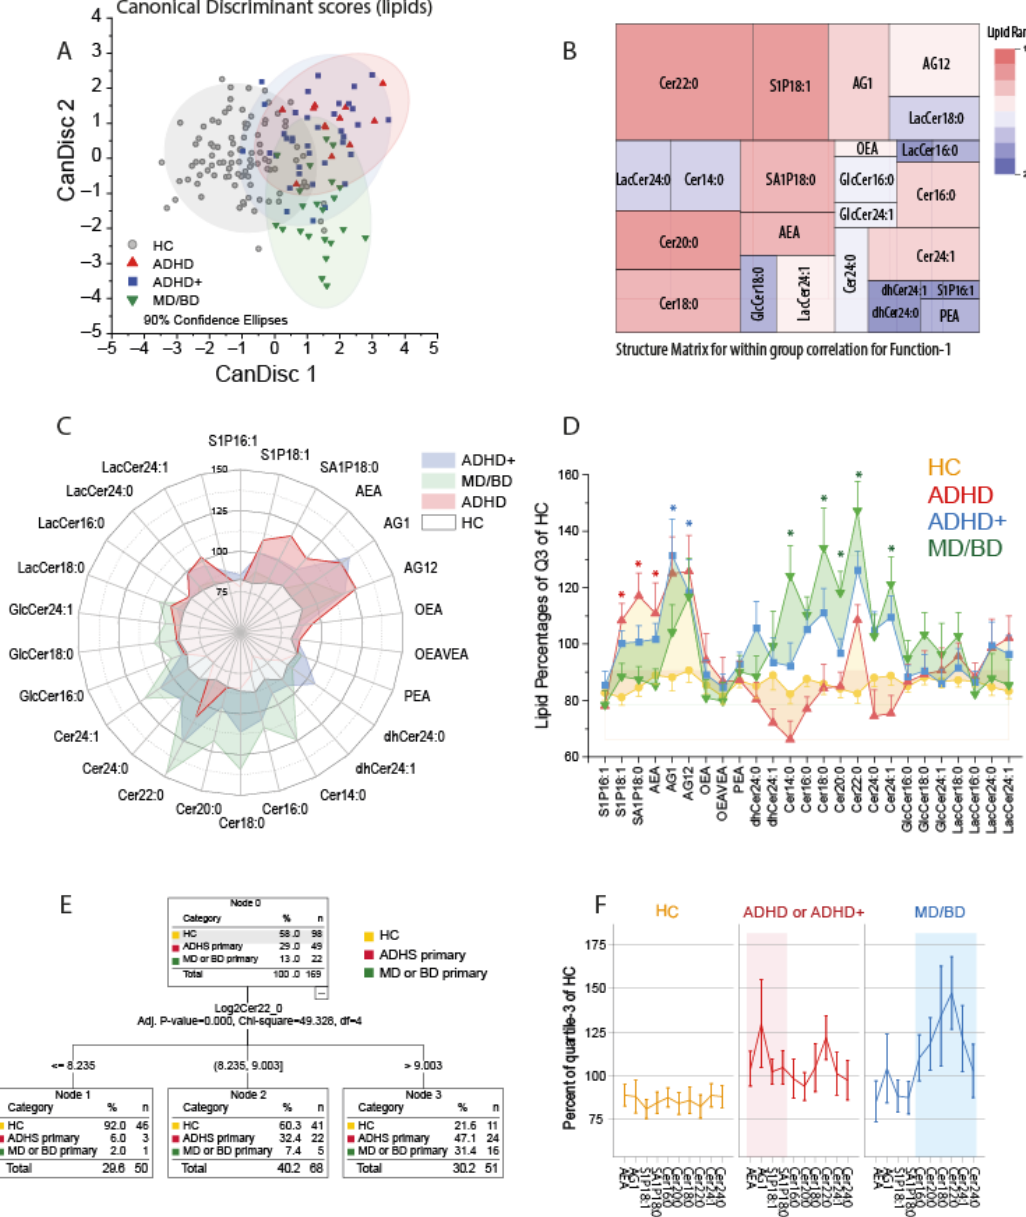
Figure 1. Canonical Discriminant Analysis, CHAID analysis and lipid profiles. ( A ): The scatter plots show the CanDisc scores for the first two functions in patients with attention-deficit/hyperactivity disorder (ADHD), ADHD with comorbidity of major depression (MD) or bipolar disorder (BD) (ADHD+), patients with MD/BD without ADHD, or healthy controls (HC). Each scatter shows one subject. The ellipses show the 90% confidence intervals (CI). Samples sizes: n = 12 ADHD, n = 37 ADHD+, n = 22 MD/BD, n = 98 HC. ( B ): Tree map of the CanDisc structure matrix for function-1, which mainly discriminates between patients and healthy controls. The CanDisc structure of function-2 is in Supplementary Figure S1A. The sizes of the rectangles and the colors reveal the relative importance of the respective lipid for the discrimination of the groups. The sizes are the within-group correlations, and the colors show the ranking. ( C ): Polar plot of the group means of lipid concentrations normalized to percentages of the 75% quantile of healthy controls. Bulges of the polar stars towards a lipid or group of lipids show that those lipids increased relative to the HC. ( D ) The area plot of the lipid profiles shows mean ± SD of normalized lipids (normalized as in ( C )). The asterisks indicate significant differences versus HC of the respective lipid according to one-way ANOVA and posthoc t -test using an alpha adjustment according to Šid á k, * adjusted p < 0.05. ( E ): Decision tree of CHAID (Chi-square automatic interaction detection) analysis. ( F ): The line graphs show the lipid profiles of the key lipids, which were selected according to the CanDisc structure matrix. ADHD and ADHD+ patients were